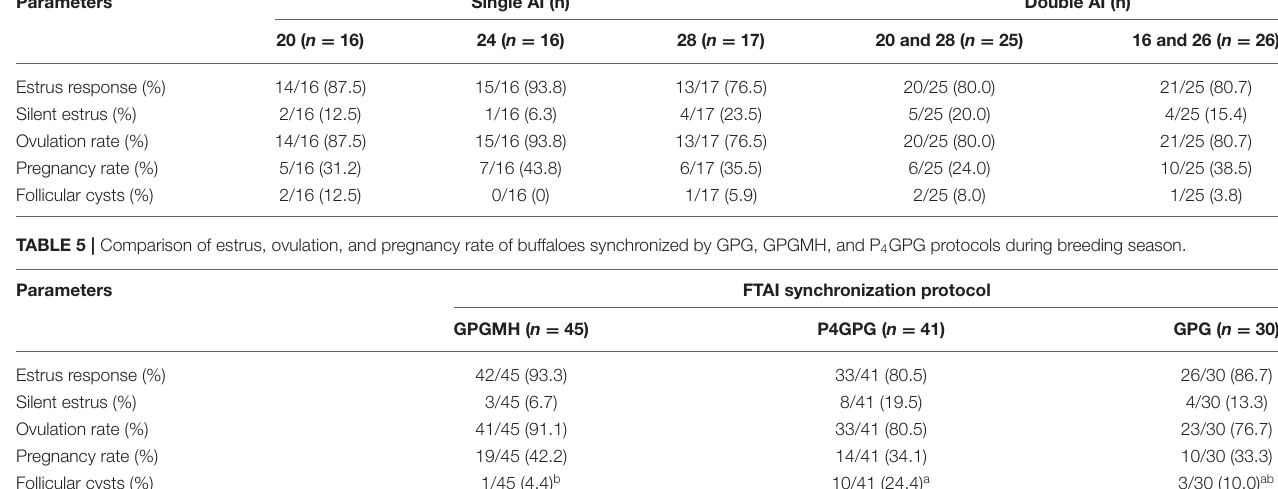
Values in brackets show the percentage of treated buffaloes for different parameters. The superscripts in different small letters (a,b) in the same row indicate a statistical difference P <